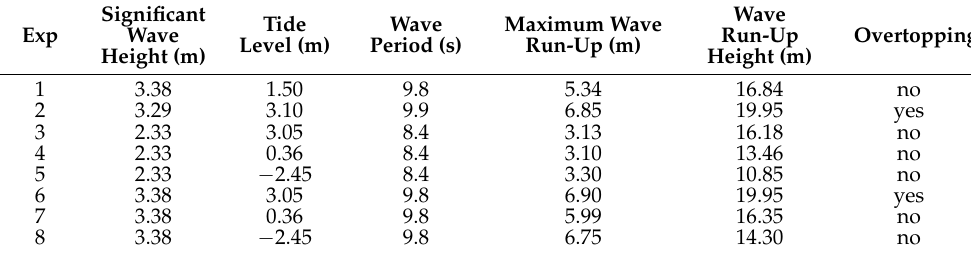
Table 2. Wave conditions and wave run-ups for Typhoon Usagi.